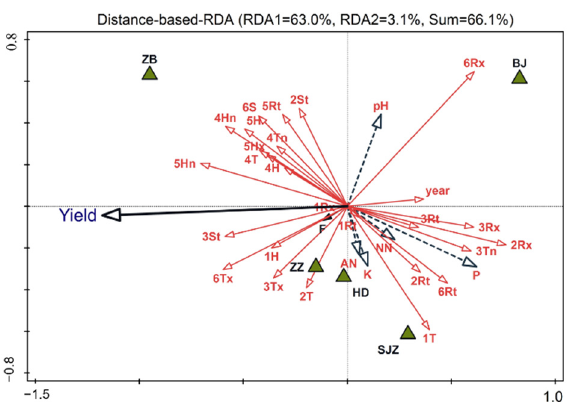
Figure 7. RDA analysis of yield, climate, and soil factors (2020–2021). ZZ, SJZ, BJ, ZB, and HD represent 5 study sites; pH, AN, NN, K, and P represent soil pH, ammonium nitrogen, nitrate-nitrogen, available potassium, and available phosphorus, respectively; The capital letters R, S, T, and H represent the average values of rainfall, sunshine time, air temperature, and air humidity, respectively. When the capital letter is followed by the small letters x, n, and t, they represent the maximum, minimum, and total values of the climate factors, respectively. The numbers in front of the uppercase letters represent the stages after seed germination. For example, 6Tn represents the minimum temperature in the 6th stage after seed germination, and 7S represents the average sunshine time in the 7th stage.